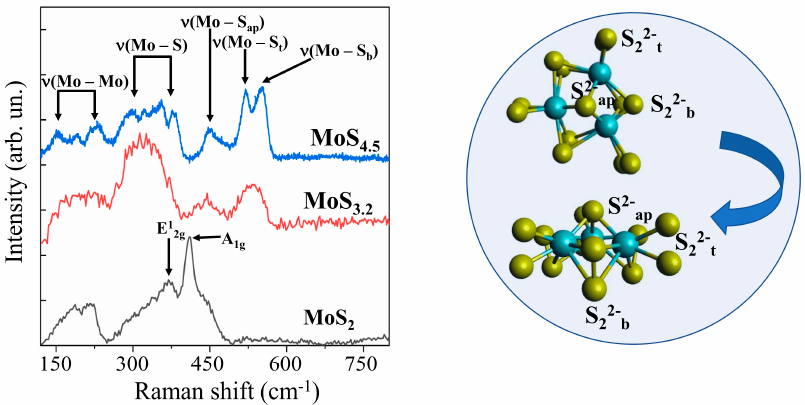
Figure 9. Raman spectra for different MoS x films obtained by RPLD. The insert shows terminal (S 22 − t ), bridging (S 22 − b ), and apical (S 2 − ap ) ligands in a 3Mo ‒ S (Mo 3 S 13 ) cluster.